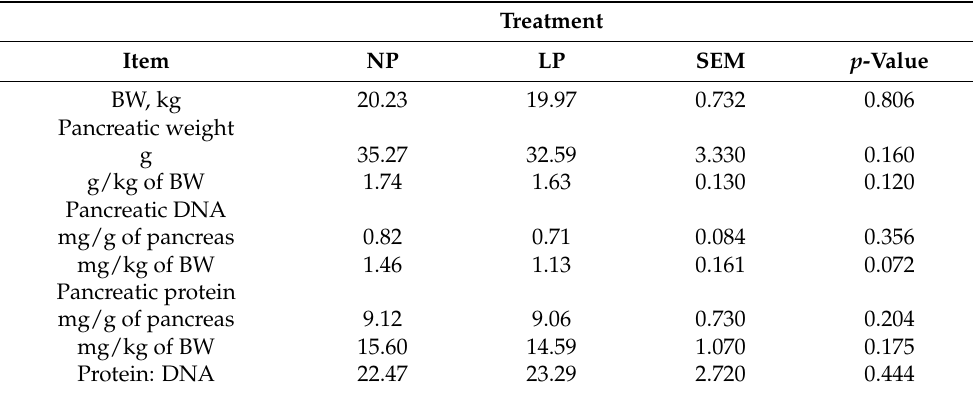
Table 3. Pancreas weight, DNA and protein contents in goats fed a low-protein diet 1 .